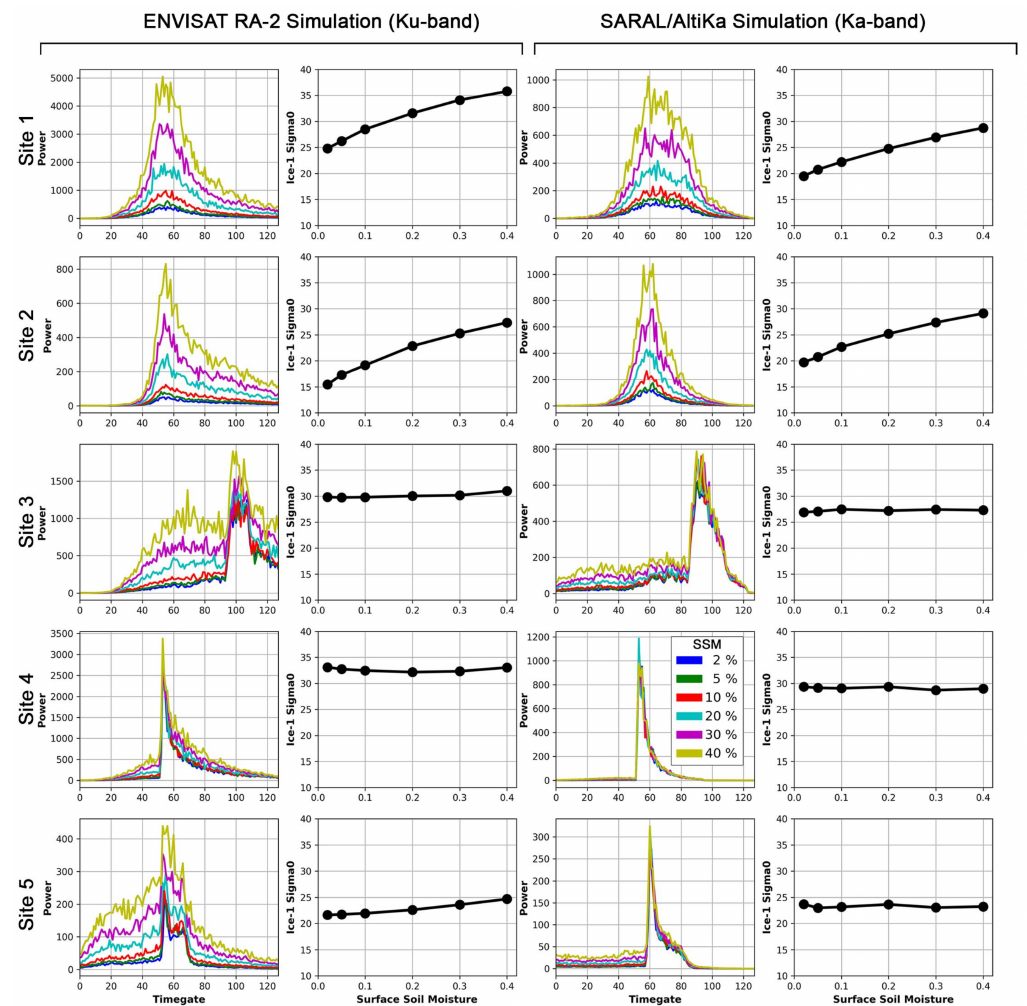
Figure 7. Simulated waveforms for increasing values of surface soil moisture (SSM) (2%—blue, 5%—green, 10%—red, 20%—light blue, 30%—purple, 40%—yellow) on the five study sites at Ku-band (left of the left panel) and at Ka-band (left of the right panel). Corresponding backscattering coefficients (dB) as a function of SSM (%) at Ku-band (right of the left panel) and from at Ka-band (right of the right